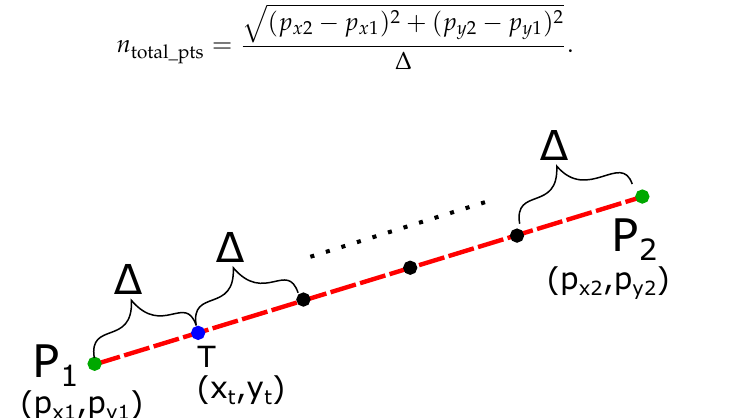
Figure 2. Discretizing the line P 1 P 2 into points x i